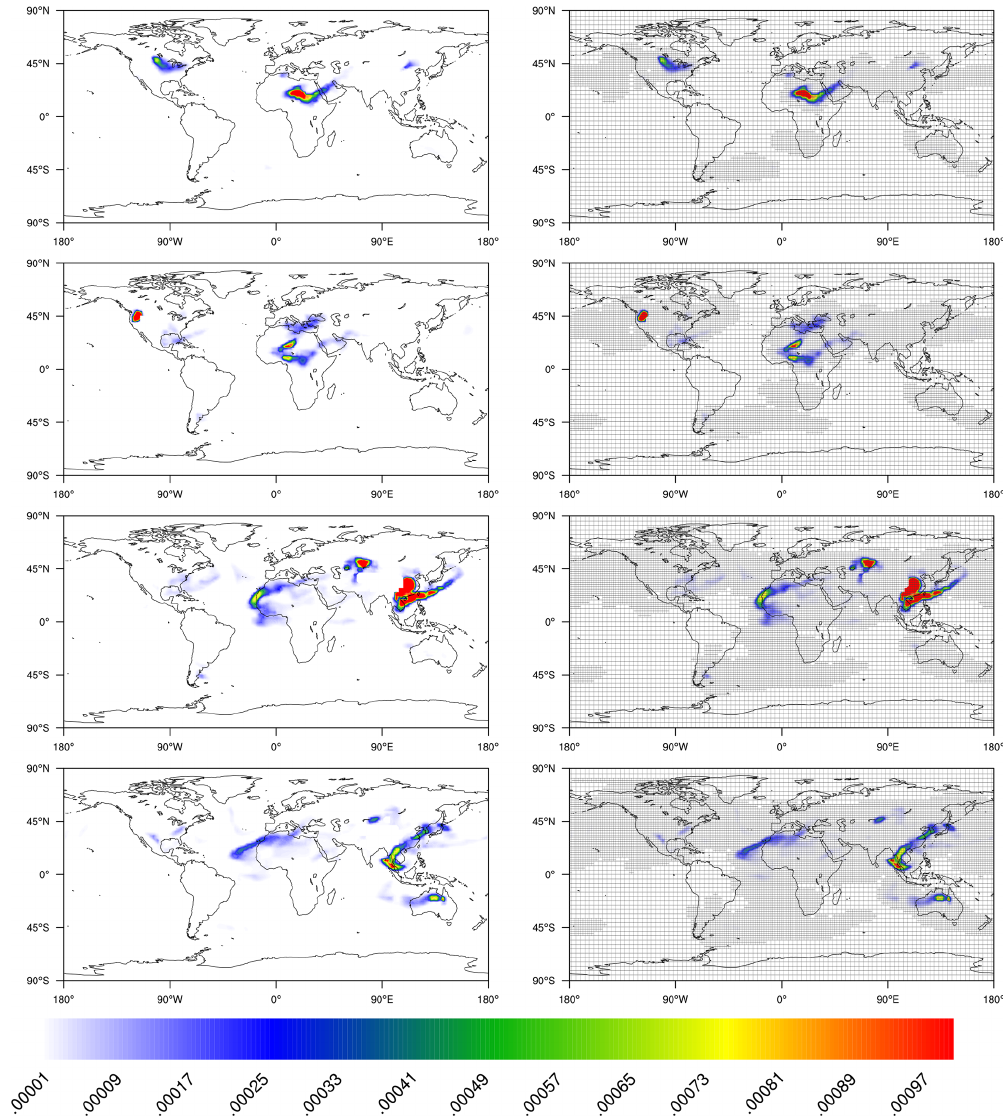
Figure 23. Dust mixing ratio of DU_AI (mgkg − 1 ) at 800hPa on 3, 6, 12, and 15 October based on a coarse model resolution of T 31 L 31. The entire model runs on T 31 L 31 with the tracer transport module at a doubled resolution in the left panel, while the dust transport is on adaptive meshes in the right